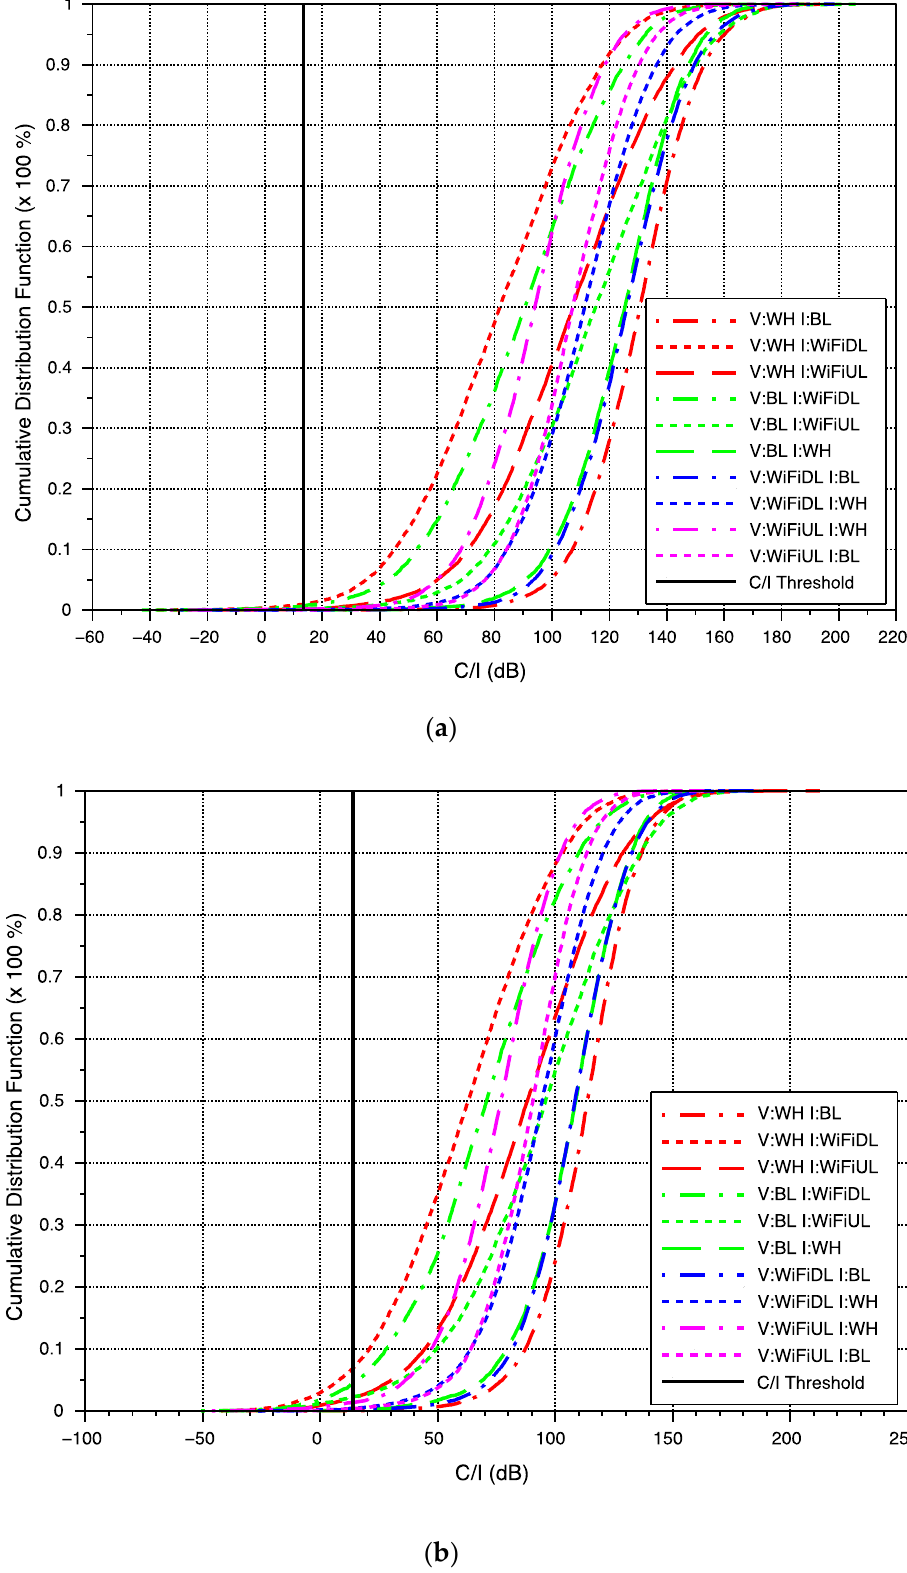
Figure 10. CDF for 10 different scenarios as a function of C / I : ( a ) 100 interferer/ha; and ( b ) 1000 interferers/ha. The black vertical line represents the interference criterion ( C / I = 14 dB).